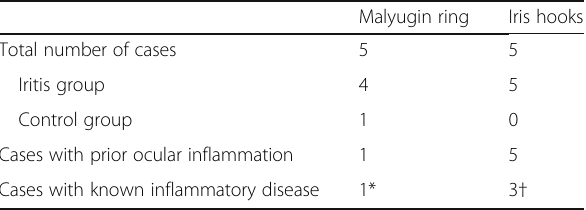
Table 4 Pupil expansion devices used for cases in the iritis and control groups and comparison of device choice based on inflammation history